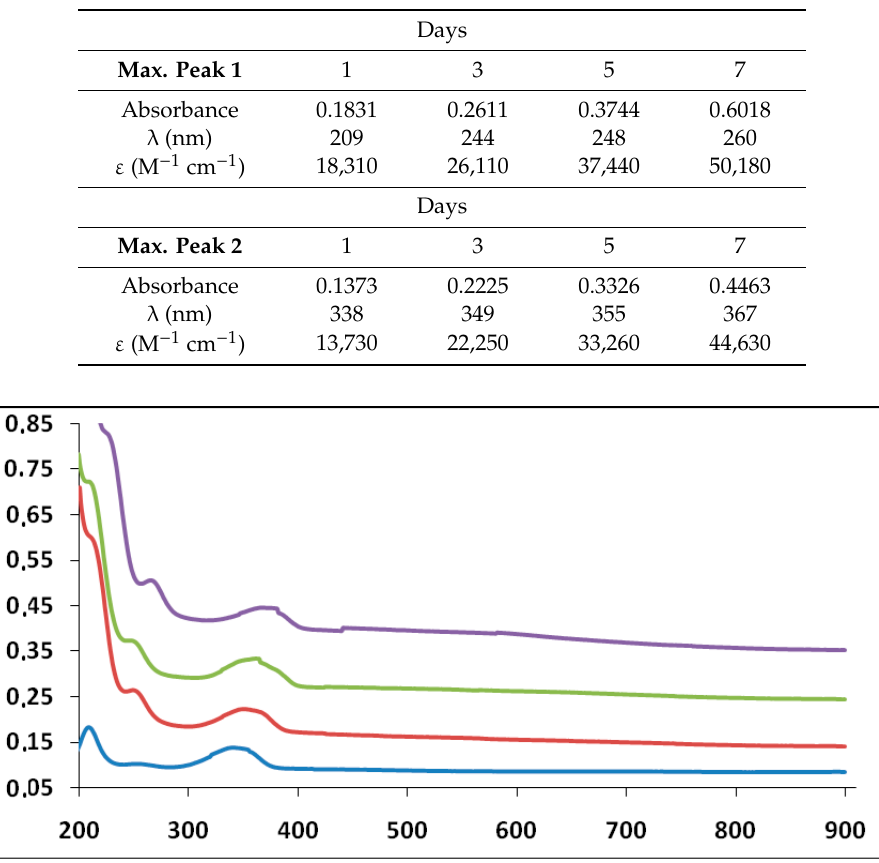
Table 2. Mesophase assignment and transition temperatures, °C (onset) a of dendritic architectures. Glass-transition ( T g ), Crystallization ( T c ), and Melting ( T m ) temperatures of G1 , G2 and G3 compounds (transition enthalpies between parenthesis; J g − 1 ).